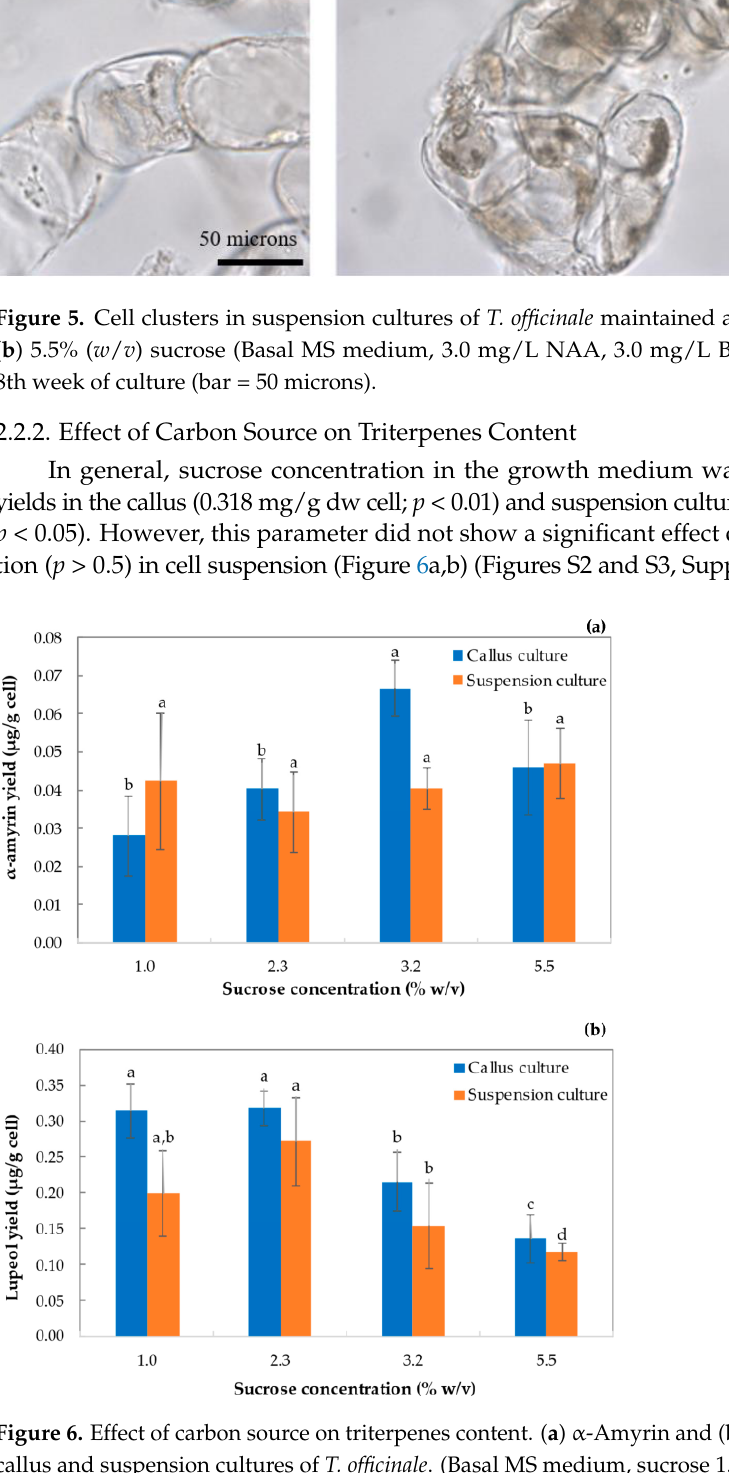
10 of 25 Figure 4. Cell growth parameters: ( a , b ) fresh and dry weight, ( c ) biomass yield (Y X/S ), and ( d ) productivity) (Q X ) in suspension cultures of T. officinale maintained at different sucrose concentra- tions (1.0, 2.3, 3.2, and 5.5% ( w / v )) (Basal MS medium, 3.0 mg/L NAA, 3.0 mg/L BAP, 20 ± 2 °C, 115 rpm, 8th week of culture). Means with the same letter above the bars were not significantly different at the 0.05 level according to the DMRT test. Bars indicate standard error. Biomass yield on the carbon source (Y X/S ) was similar for all the conditions tested. Y X/S values of 223, 237, 236, and 257 mg/g were obtained for suspension cultures maintained at 1.0%, 2.3%, 3.2%, and 5.5% ( w / v ), respectively (Y X/S was calculated with Equation (4), see methods). Thus, carbon source concentration was not statistically significant ( p = 0.68) on biomass yield, and it can be considered to have an average value of 238 mg/g. Cell productivity (Q x , in dw) values for cultures maintained at 1.0%, 2.3%, 3.2%, and 5.5% ( w / v ) of sucrose had values of 0.8, 1.5, 0.7, and 0.4 g/L-week, respectively (Q x was calculated with Equation (5), see methods). Statistically, the analysis indicated that the effect of su- crose concentration was significant on cell productivity. In Figure 5a,b, suspension cultures of T. officinale maintained at 1.0% ( w / v ) and 5.5% ( w / v ) of sucrose are shown, respectively. At the lower carbon source concentrations, a pre-